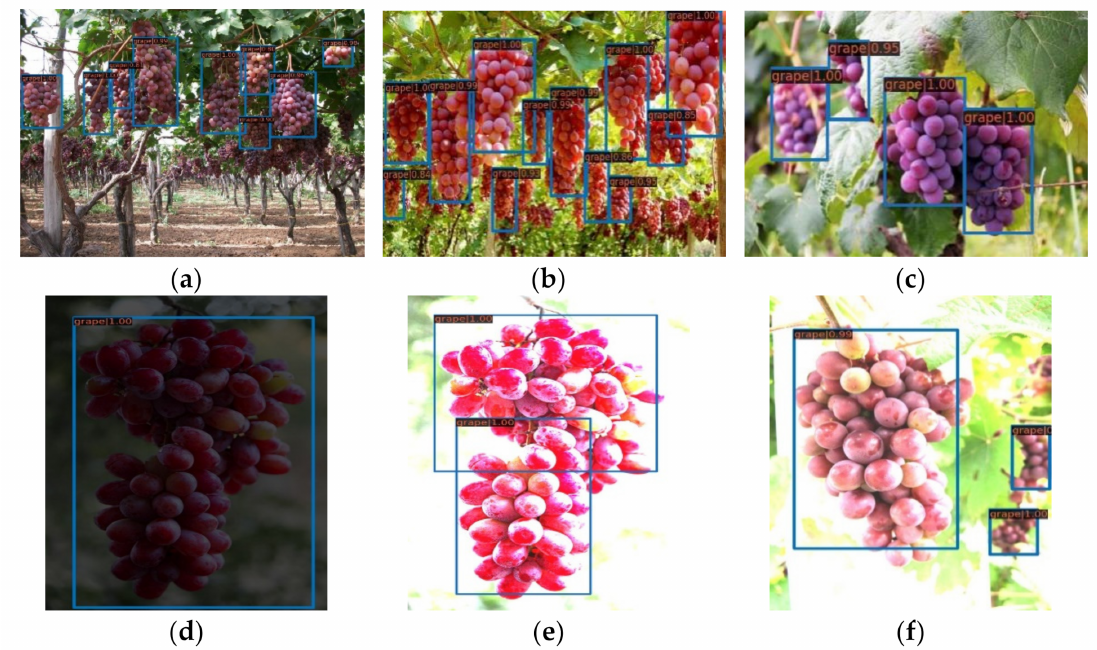
Figure 7. Sample pictures of SwinGD detection ( a – f ). Images are obtained from Baidu